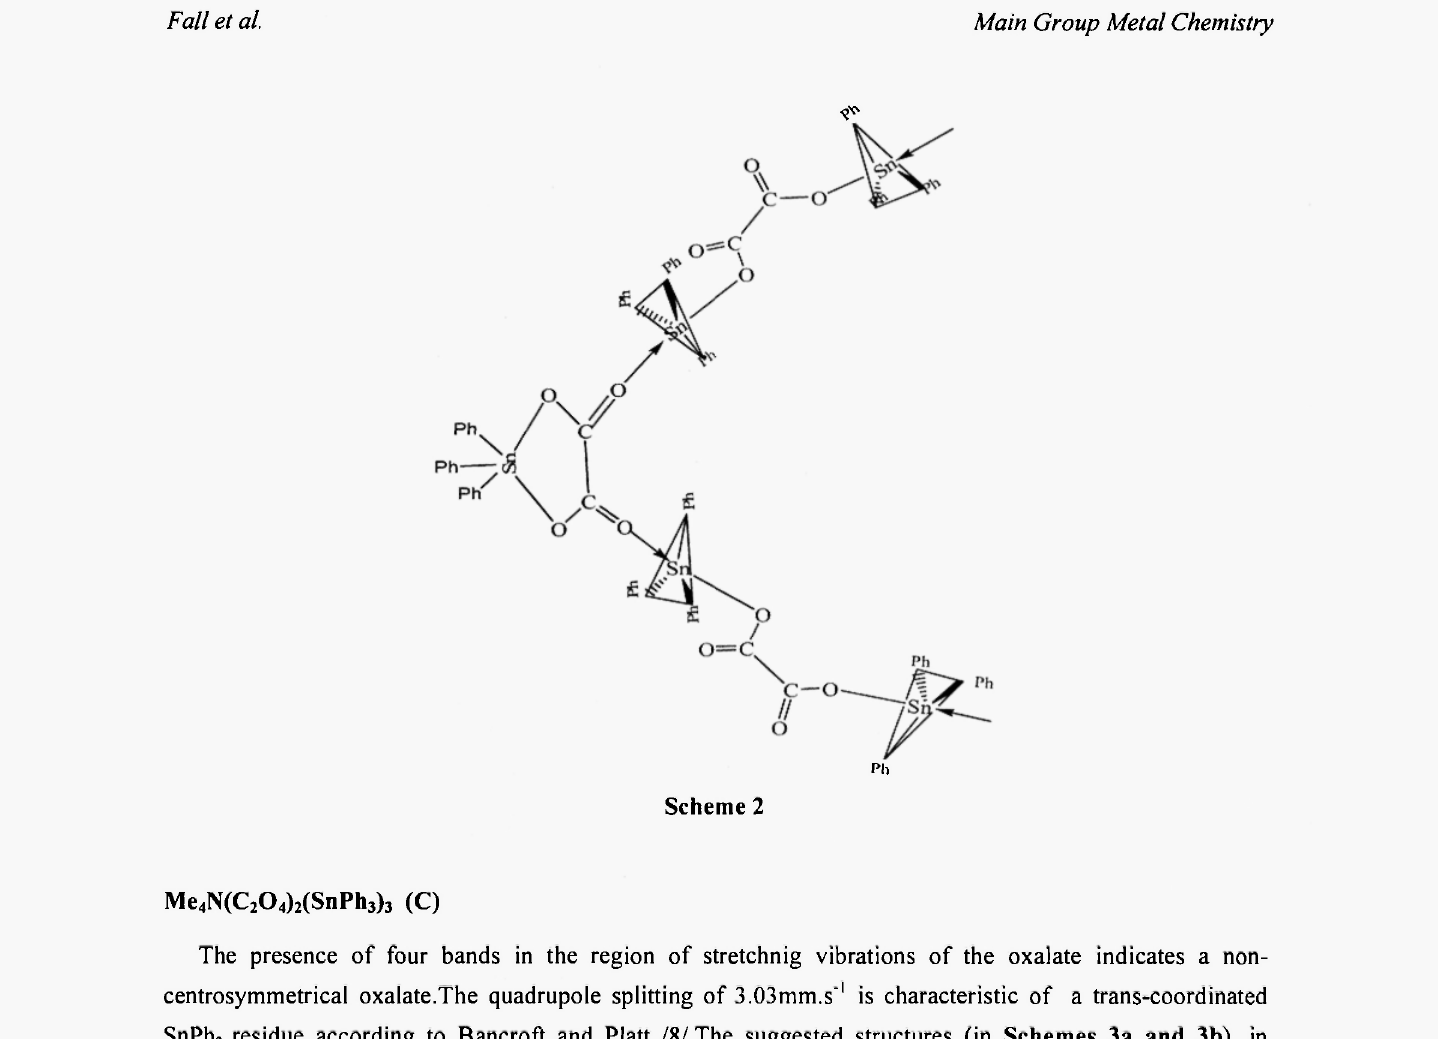
The presence of four bands in the region of stretchnig vibrations of the oxalate indicates a non- centrosymmetrical oxalate.The quadrupole splitting of 3.03mm.s" 1 is characteristic of a trans-coordinated SnPh 3 residue according to Bancroft and Piatt /8 /.The suggested structures (in Schemes 3a and 3b), in agreement with the spectroscopic data, are similar to the structures of Et 4 N(Mo0 4 ) 2 (SnPh 3 )3 /10/